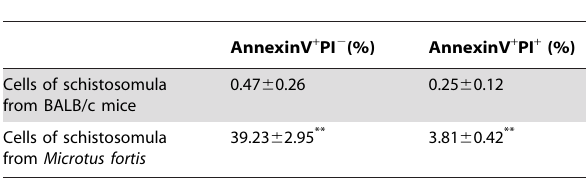
Table 4. Apoptosis and necrosis in cells of schistosomula taken from the two host species determined by Annexin V- FITC/PI analysis (Mean 6 SD;